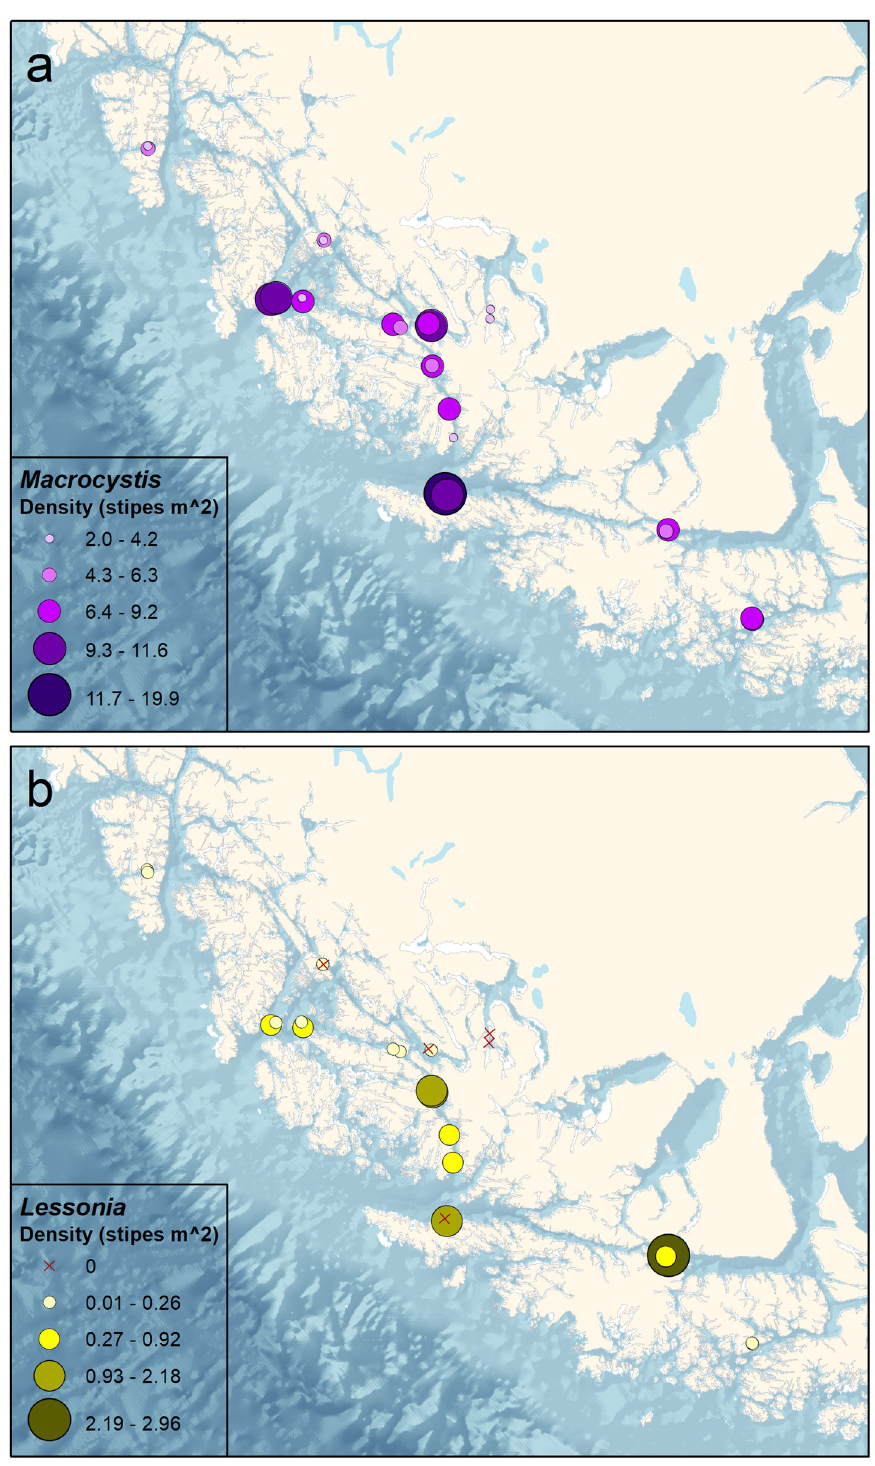
Fig 3. Densities (number of stipes m -2 ) of kelp taxa in the Kawe´sqar National Reserve. (A) Macrosystis pyrifera and (B) Lessonia spp.